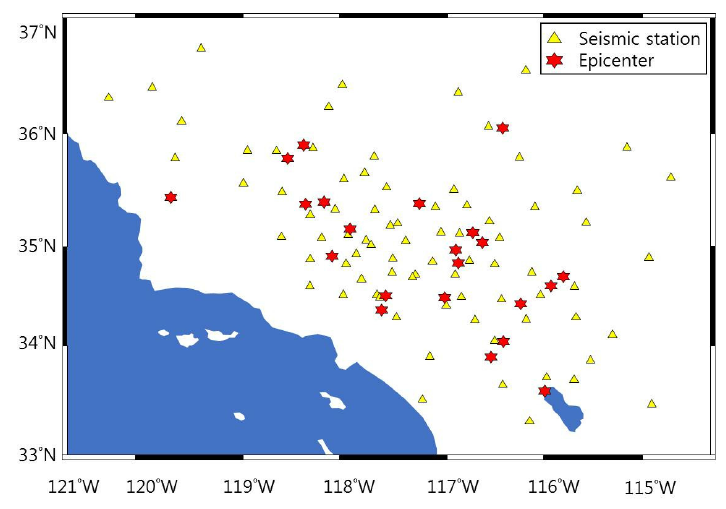
Figure 1. Location of seismic stations of SCSN and the epicenters of